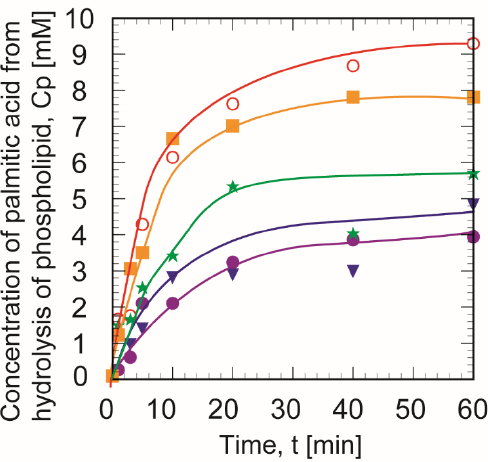
Figure 7. Time course of palmitic acid concentration (Cp) produced with immobilized phospholipase A 1 in various amounts of water. The volumetric amount of the supplemental acetate buffer solution, Hb was changed as follows; 0 ( ★ ), 0.05 ( ● ), 0.075 ( ○ ), 0.1 ( ▼ ), and 0.2 ( ■ ) mL. The C GA was set at 6%. The experiments were each conducted a minimum of three times.